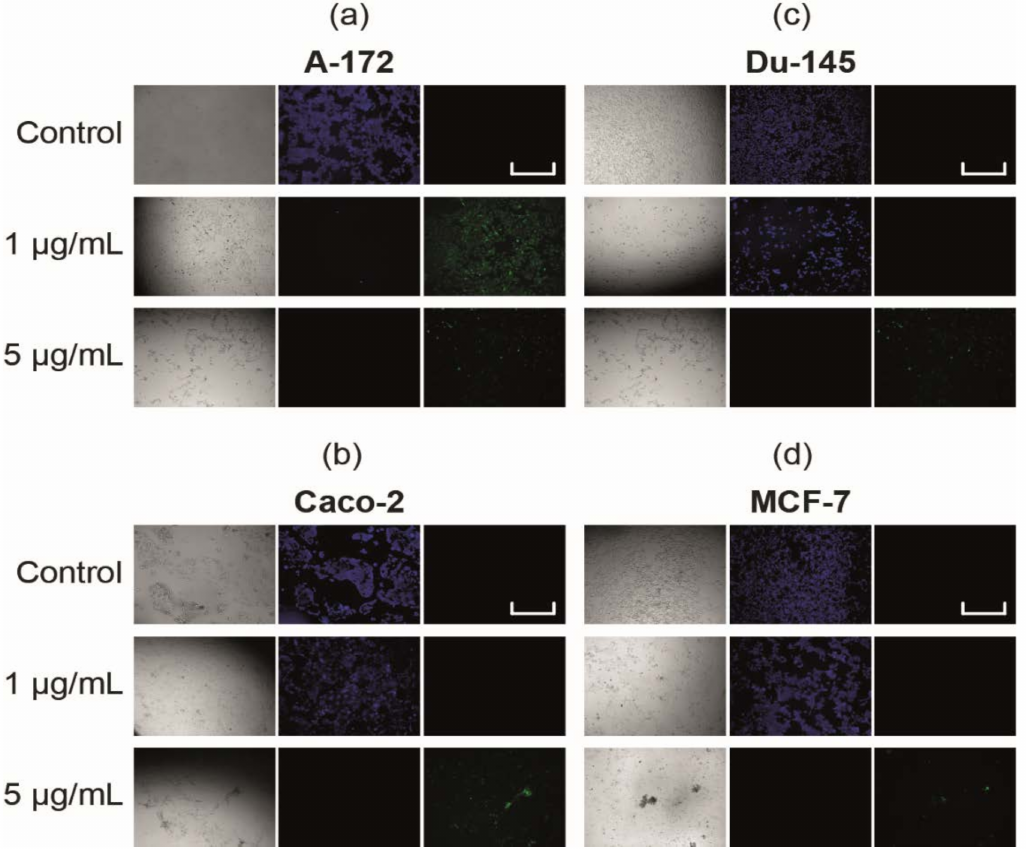
Figure 3. Apoptosis induction in cancer cells by SeNP ( a )—A-172; ( b )—Caco-2; ( c )—Du-145; ( d )—MCF-7. Cells were incubated with various concentrations of SeNP for 24 h. Apoptotic cells were visualized using the FITC channel (Ex/Em = 490/525 nm). To detect healthy cells, CytoCalcein 450 was used and cells were visualized using the violet channel (Ex/Em = 405/450 nm). Data are expressed as percentage of control (intact cells; set to